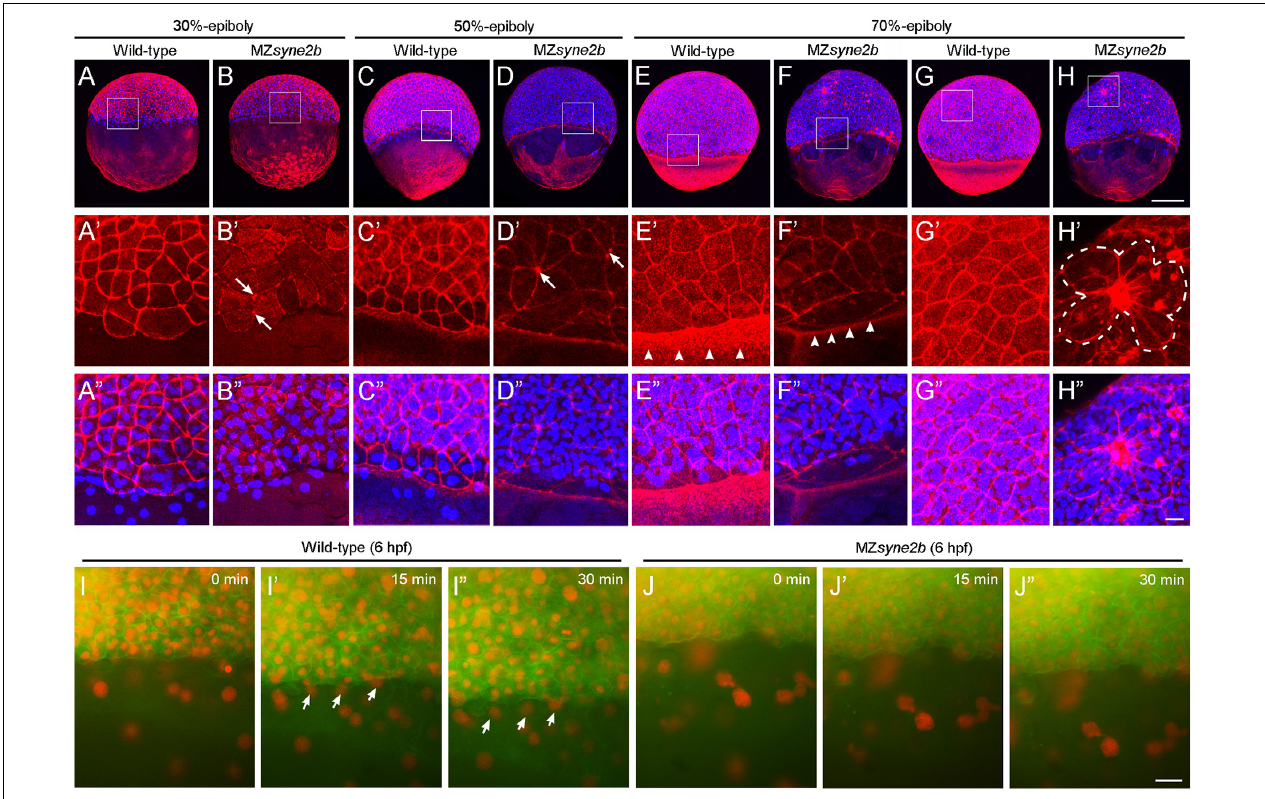
FIGURE 4 | Disruption of Syne2b function affects F-actin organization, EVL cell shape and YSN movements. Phalloidin and DAPI staining of stage-matched embryos. (A–A (cid:48)(cid:48) ) Wild-type embryos at 30% epiboly show strong phalloidin staining in the cortex of EVL cells. A ring of YSN are apparent at the EVL margin. (B–B (cid:48)(cid:48) ) MZ syne2b embryos at 30% epiboly show reduced and clustered (arrows) phalloidin staining in EVL cells. Few YSN are present at the EVL margin. (C–C (cid:48)(cid:48) ) In wild-type embryos at 50% epiboly, phalloidin staining is present strongly in the cortex of EVL cells and uniformly in the yolk cell. YSN are still present at the EVL margin. (D–D (cid:48)(cid:48) ) In MZ syne2b embryos at 50% epiboly, phalloidin staining is clustered at multiple cell contact regions in the blastoderm (arrows) and is disrupted in the yolk cell. Few YSN are scattered in the yolk cell. (E–E (cid:48)(cid:48) ) In wild-type embryos at 70% epiboly, thick actin rings are formed around the blastoderm margin (arrowheads). (F–F (cid:48)(cid:48) ) MZ syne2b embryos at 70% epiboly form weak and thin marginal actin rings (arrowheads). YSN remain scattered in the yolk cell. (G–G (cid:48)(cid:48) ) Regular cortical F-actin and cell shape in the blastoderm of wild-type embryos. (H–H (cid:48)(cid:48) ) Severely disrupted cell shape and rearrangements in the blastoderm of MZ syne2b embryos, with the occurrence of rosette structures (broken lines). (I,J (cid:48)(cid:48) ) Still frames from time-lapse imaging show YSN movements at 50% epiboly. Note that YSN emerge from the front of the EVL margin during epiboly in wild-type embryos (arrows). Scale bars: (A–H) 200 µ m; (A (cid:48) –H (cid:48)(cid:48) ) 20 µ m; (I–J (cid:48)(cid:48) ) 100 µ